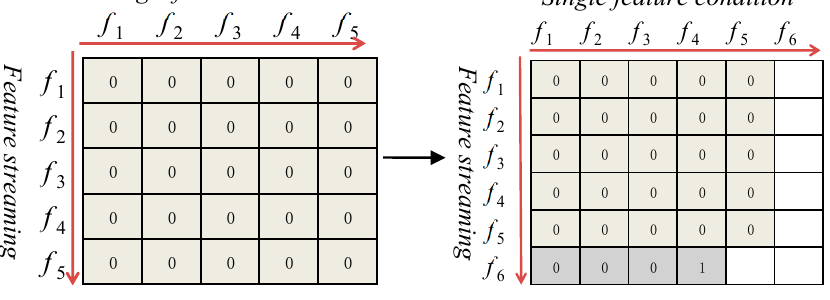
Figure 4. Filtering of single ‐ conditional independence 1.